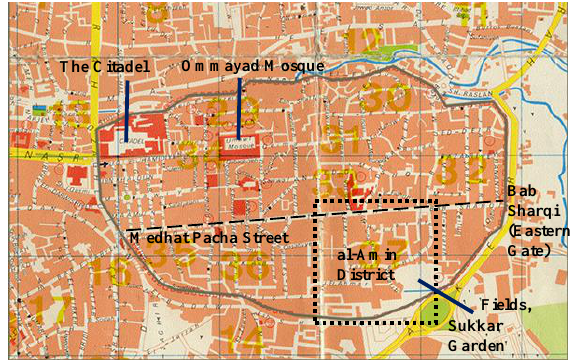
Figure 1. Location of al-Amin district in the Old City of Damascus, Touristic map, Archive IFPO.